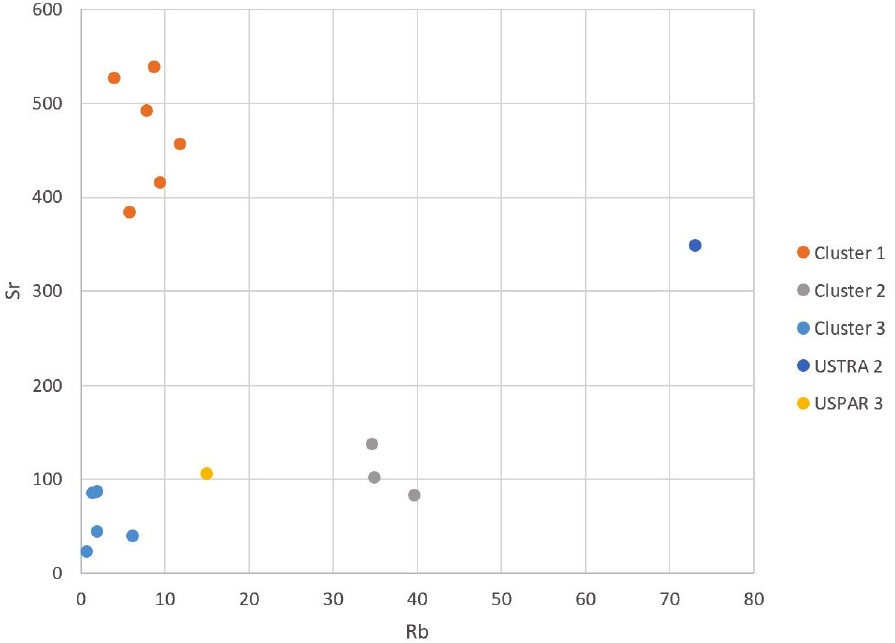
Figure 8: Three clusters and two outliers are defined, based on rubidium and strontium which were used as proxies respec- tively for potassium and